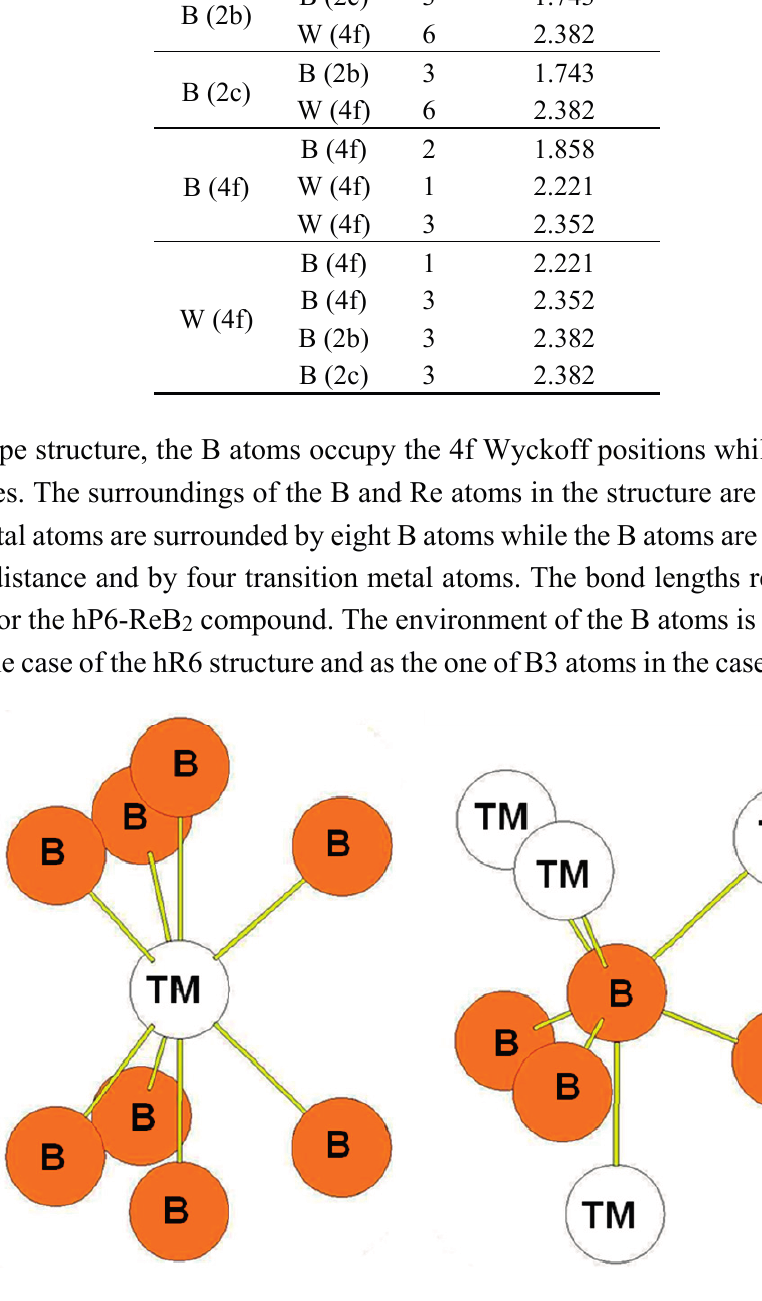
Figure 8. Environment of TM and B atoms in the hP6 (ReB 2 -type) structure. Table 7. Bond lengths in the hP6-ReB 2